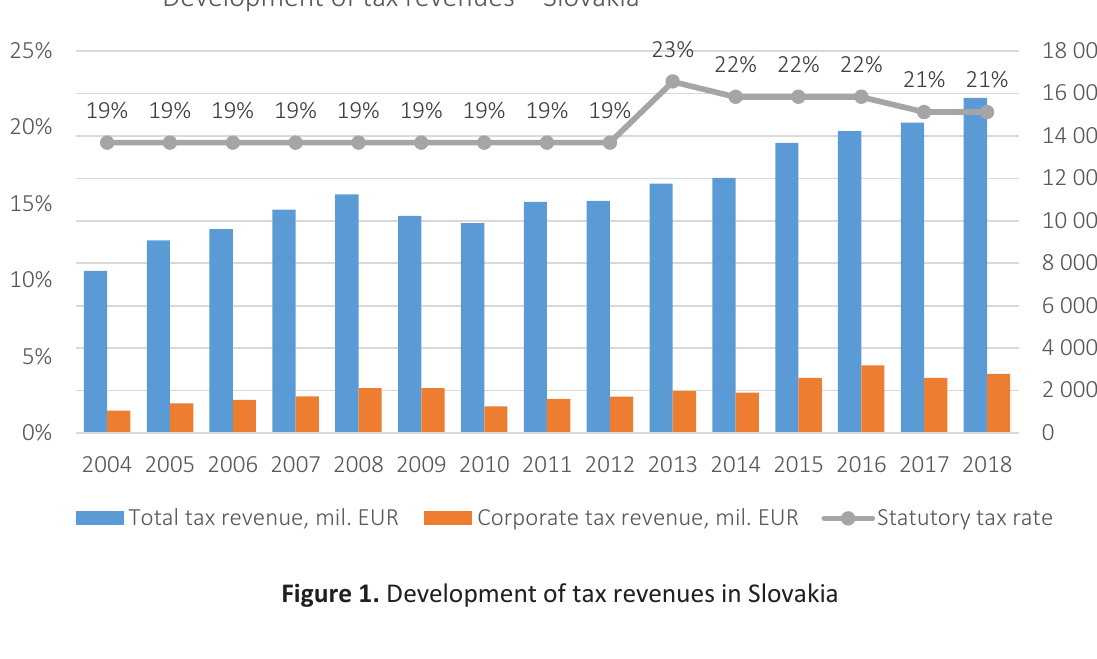
Figure 1. Development of tax revenues in Slovakia